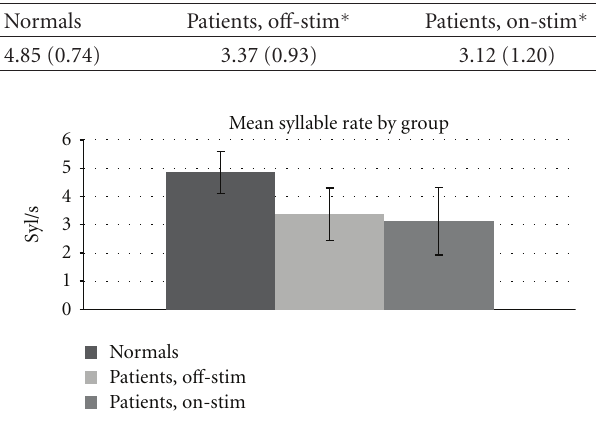
Figure 1: Mean syllable rate across treatment condition. Patients di ff erent from normal, P ≤ . 001.